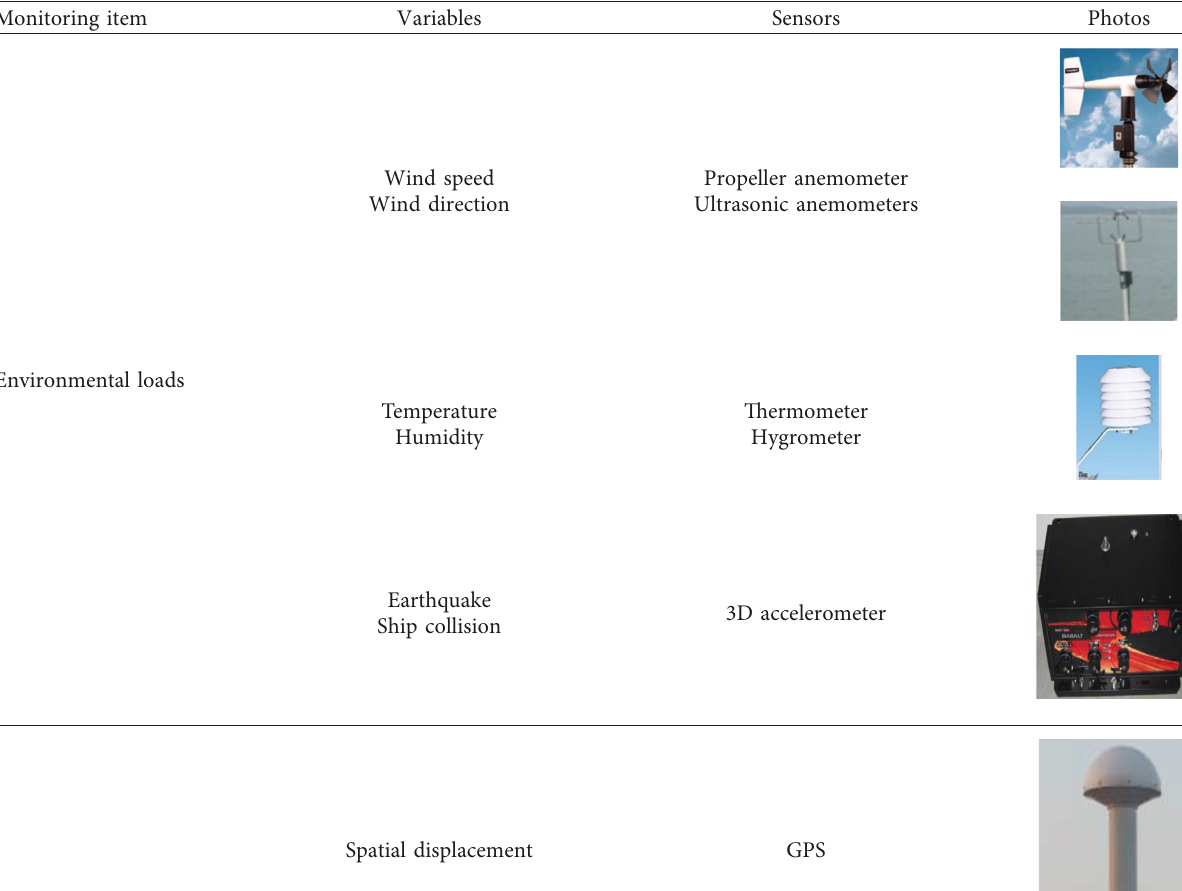
Table 1: Monitoring contents and corresponding